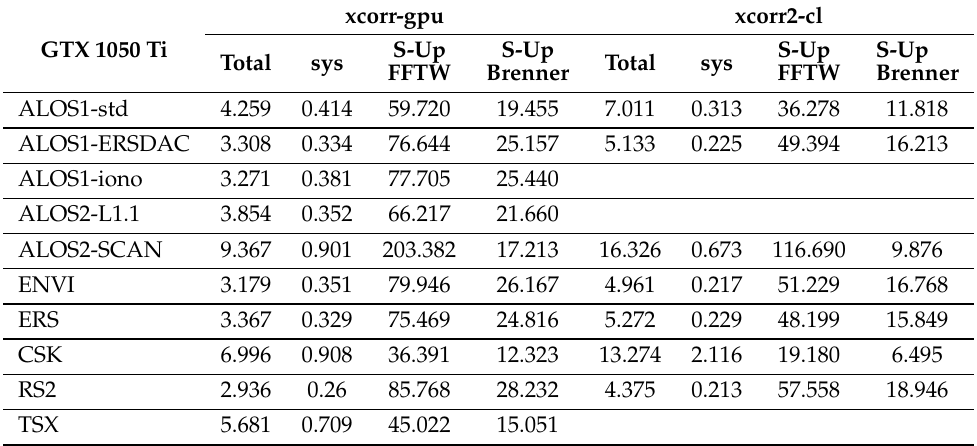
Table 7. Execution times and Speed-Up for xcorr-gpu , xcorr2-cl on GTX 1050 Ti hardware configuration. Figures in total and sys columns are expressed in seconds, where sys represent the time spent in Supervisor mode. S-Up columns represent speed-ups expressed with respect to xcorr execution times using both FFTW and Brenner